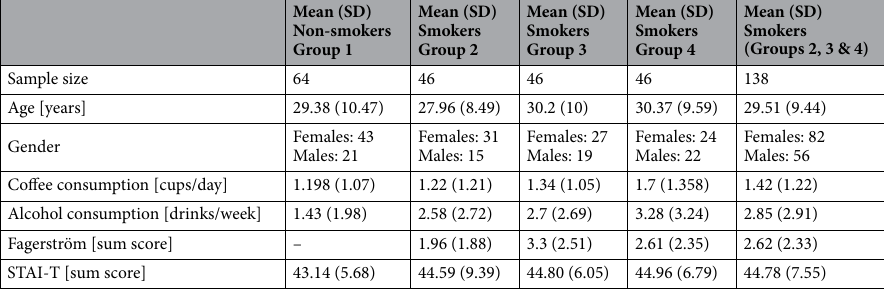
Table 1. Demographics for each group separately and for all smoker groups combined. Group 1 contains only non-smokers, group 2 contains smokers that took a smoking break of 6 h after fear acquisition on day 1, group 3 contains smokers that smoked a cigarette directly after fear acquisition on day 1 and group 4 contains smokers that smoked a cigarette directly before fear acquisition on day 1. The last column contains all smokers from groups 2, 3 and 4